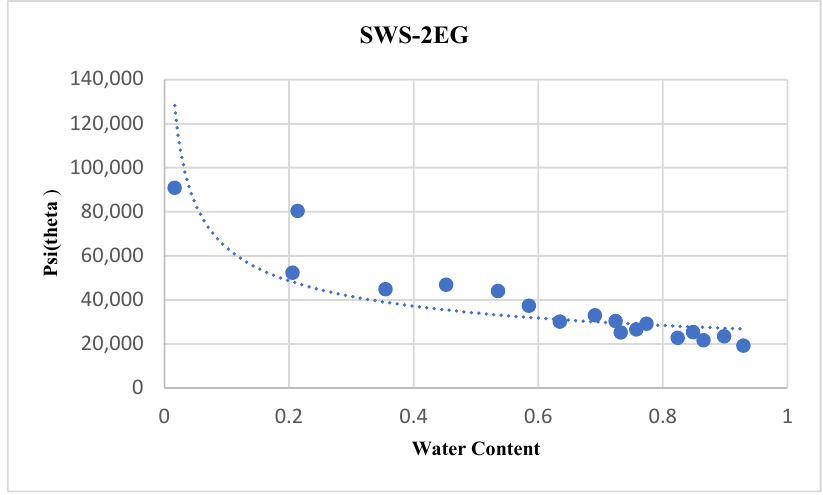
Figure 8. Decay model for SWS-2EG.